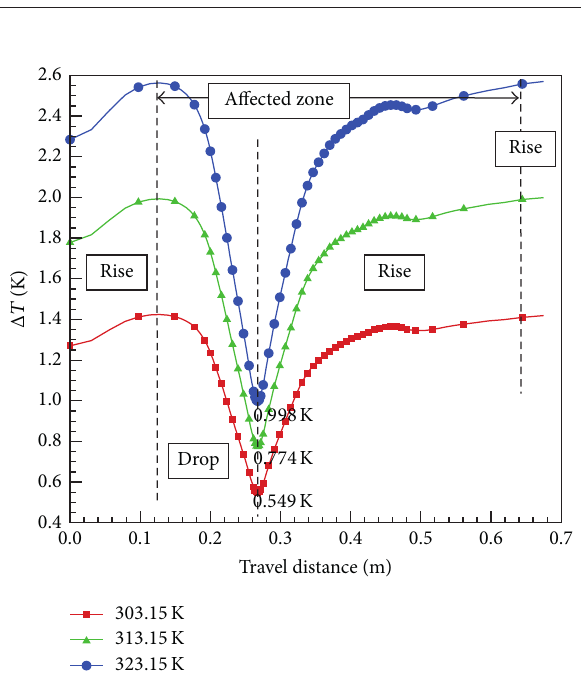
Figure 3: Effect of inlet temperature on temperature drop along the extrados of